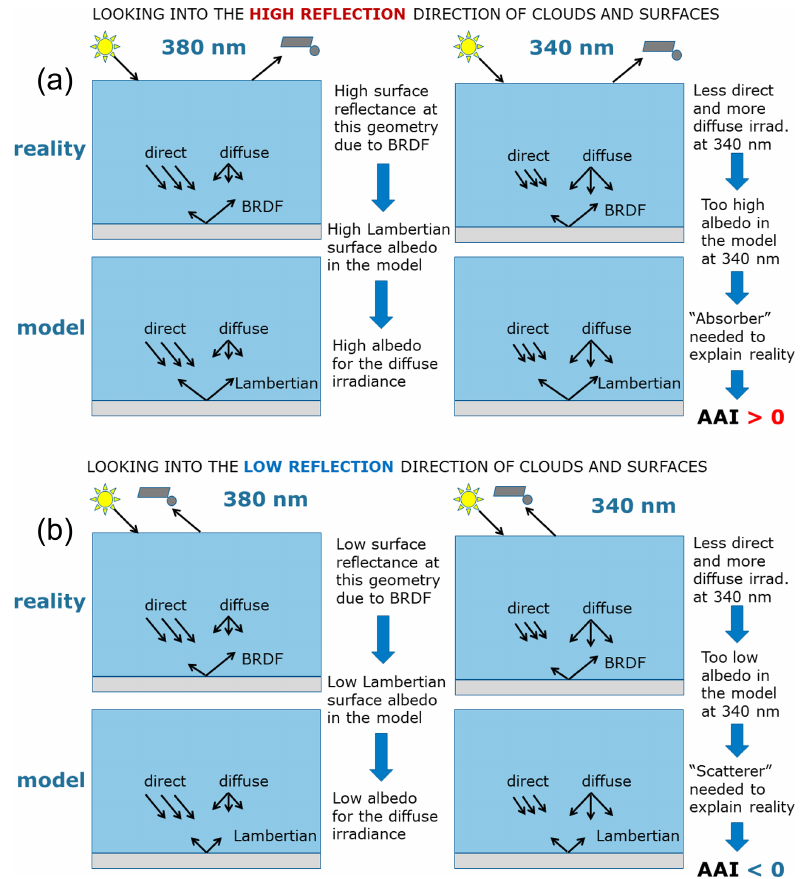
Figure 6. (a) The effect of BRDF on the AAI for the high reflection part of the BRDF of the cloud or surface, leading to an enhanced, more positive AAI. (b) Same as panel (a) but for the low reflection part of the BRDF, leading to a reduced, more negative